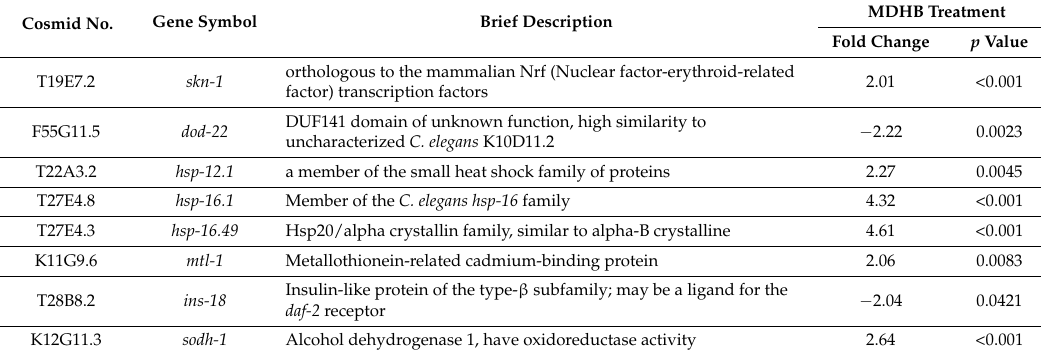
Table 2. Effects of MDHB on the expression of partial daf-2 / daf-16 -dependent targets. Cosmid